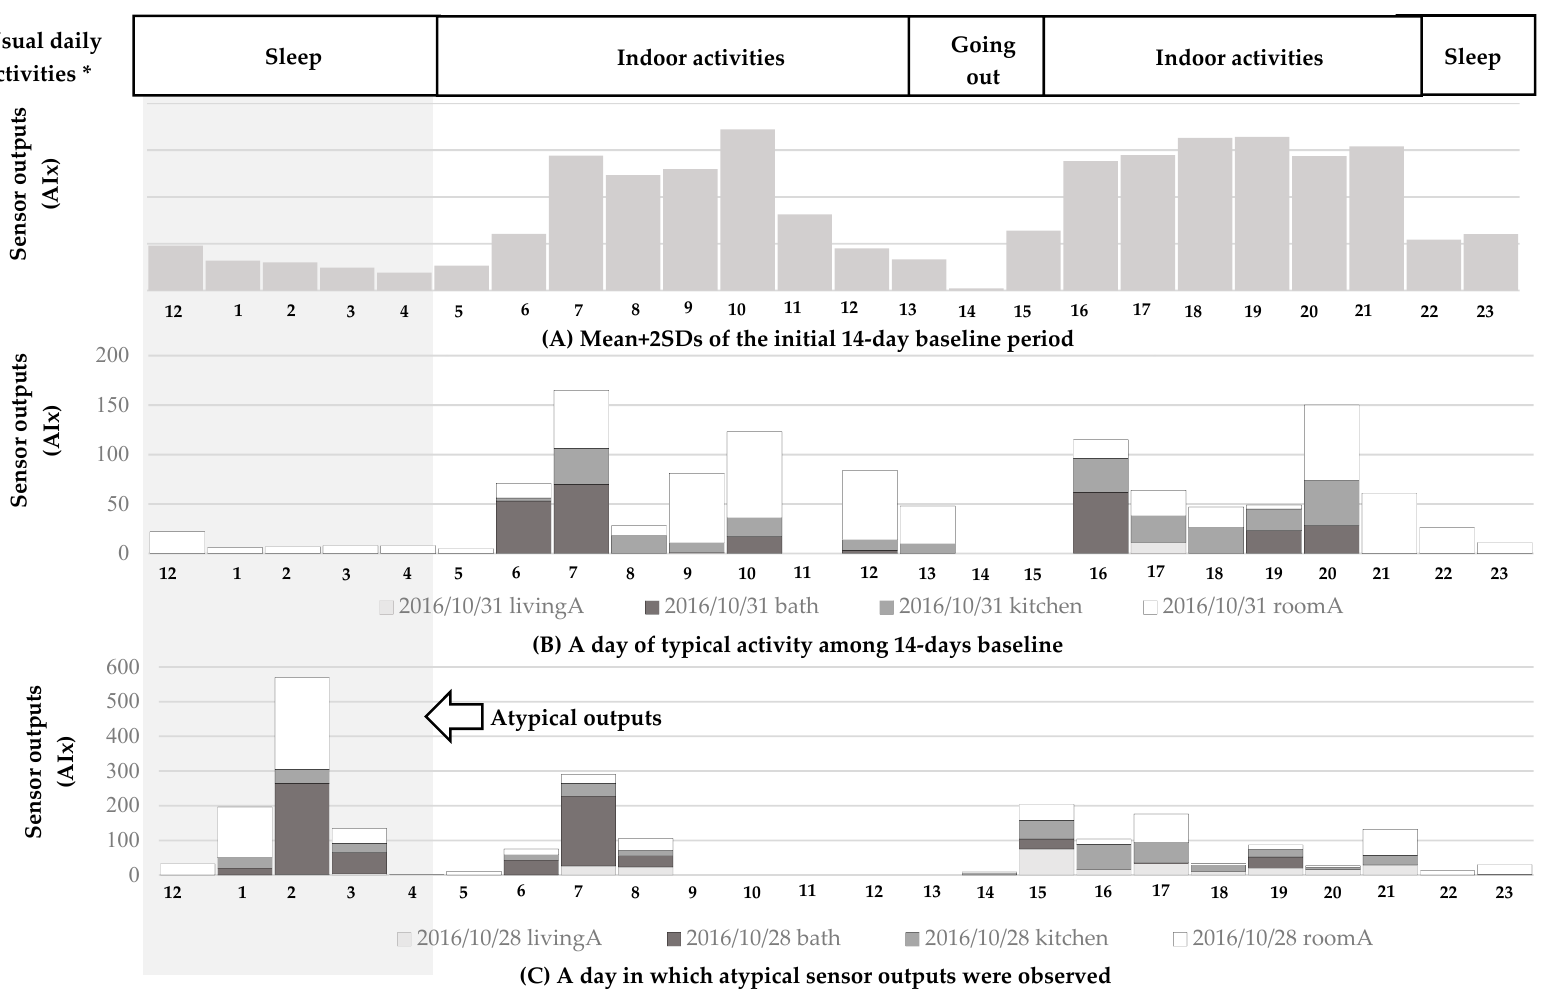
(A) Mean+2SDs of the initial 14-day baseline period